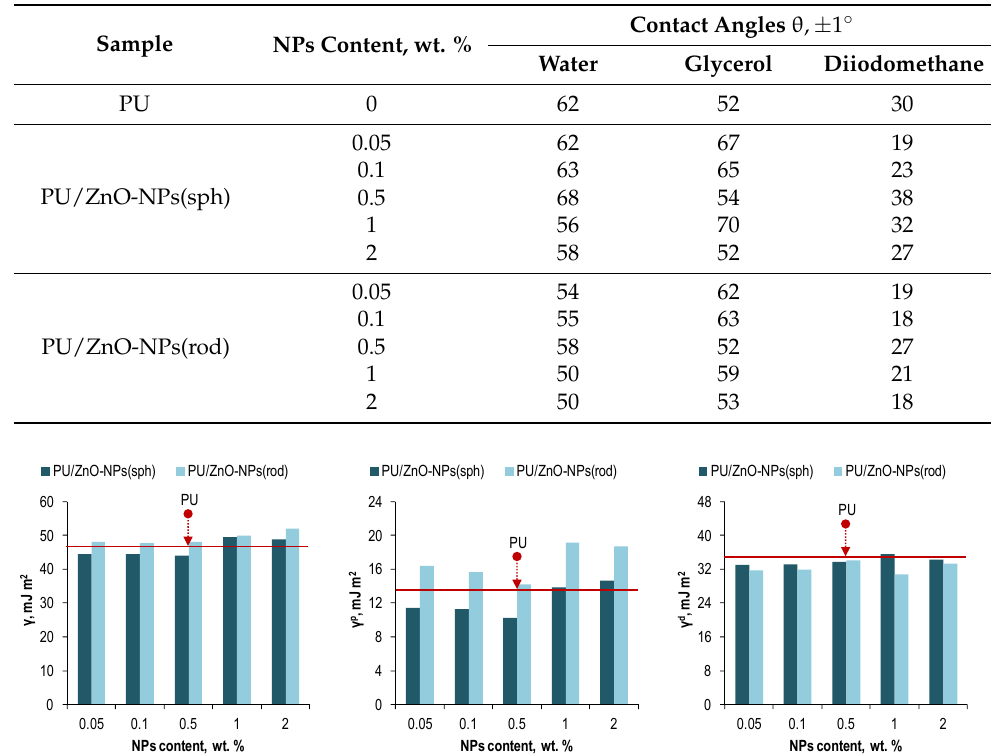
Table 3. The contact angles of the polymeric membranes. Sample